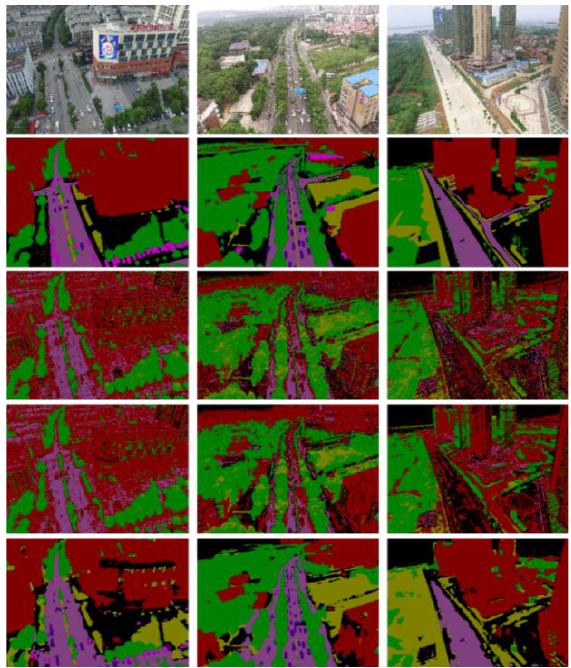
Figure 8 . Segmentation results of U-Net, RF, and MLP models on the UAVid2020 test set. The first row shows the original image. The second row shows the ground truth images. The three last rows show the results of the RF, MLP, and U-Net models,